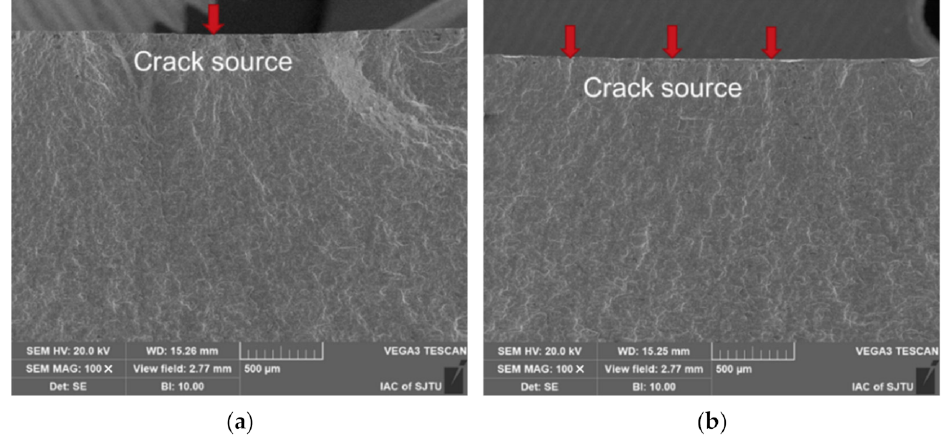
Figure 11. SEM micrographs revealing crack sources for specimens ( a ) with LSP and ( b ) without LSP.